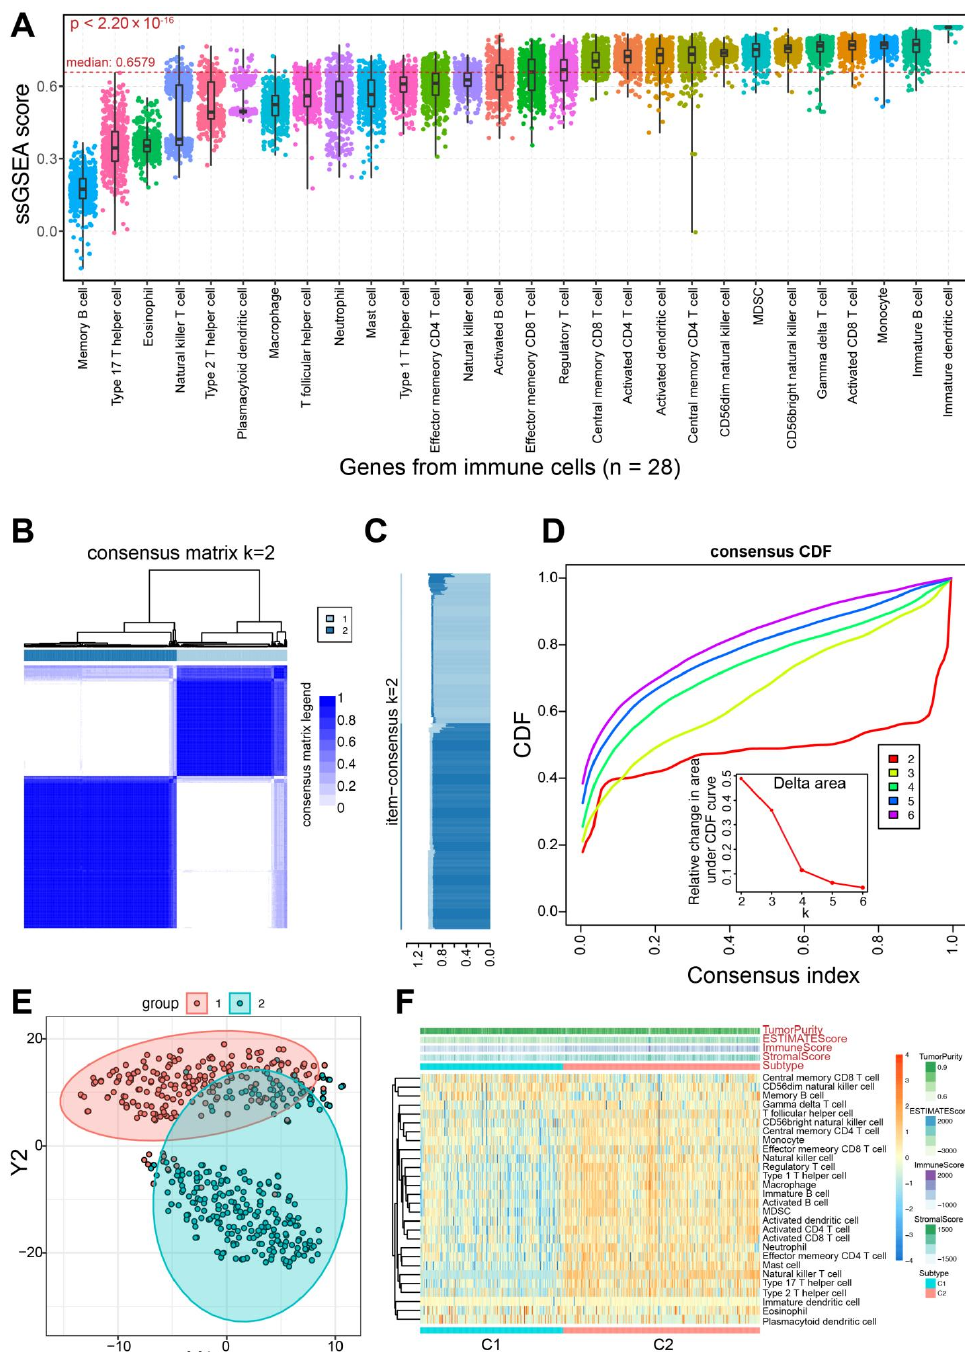
Figure 1. Identifying immune-based molecular subtypes in prostate cancer. ( A ). Distributions of ssGSEA scores are presented across different gene sets from 28 immune cells, and the total median value is highlighted (0.6579). The p value is estimated using a trend test. ( B ). The consensus score matrix for PRAD samples (k = 2) indicates that the two clusters can be divided. ( C ). The item- consensus analysis shows that k = 2 is an optimal selection. ( D ). Cumulative distribution function (CDF) curve of the consistency score shows that k = 2 is an optimal selection based on different subtype numbers (k = 2–6). Delta area plot of the relative change in area under CDF curve is also presented. ( E ). The two clusters can be distinguished based on ssGSEA scores using principal component analysis (PCA) of all samples. Each point indicates a patient, and different colors indicate the relevant subtypes. ( F ). A heatmap of immune characteristics based on ssGSEA scores shows the whole distributions in the two identified